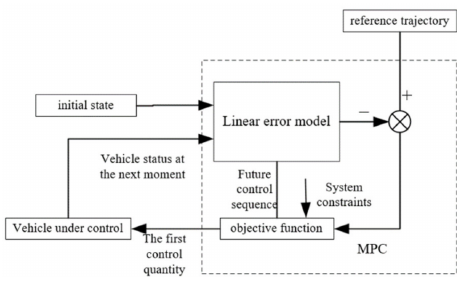
Figure 5. Flow chart of linear time-varying model